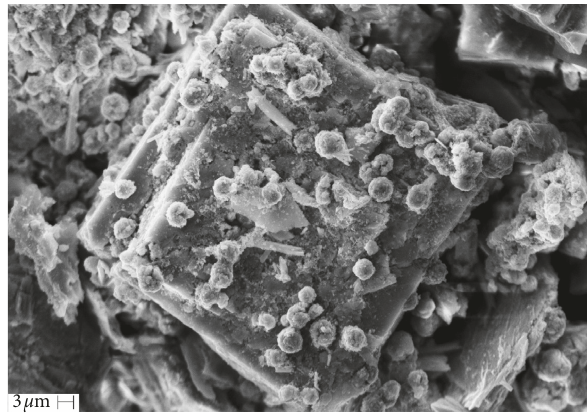
Figure 5: SEM image ( reaction.